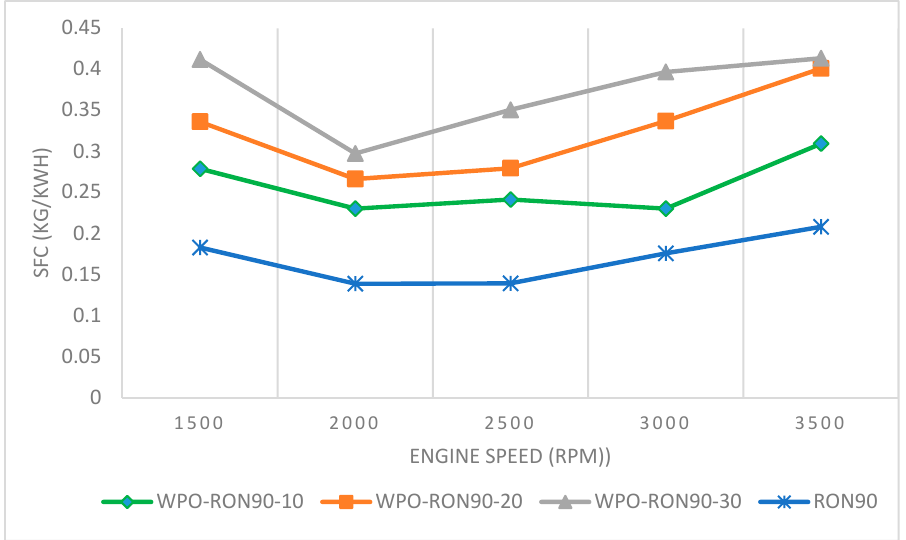
Figure 9. The effect of WPO-RON90 blend on SFC compared to RON90. Figure 9. The e ff ect of WPO-RON90 blend on SFC compared to